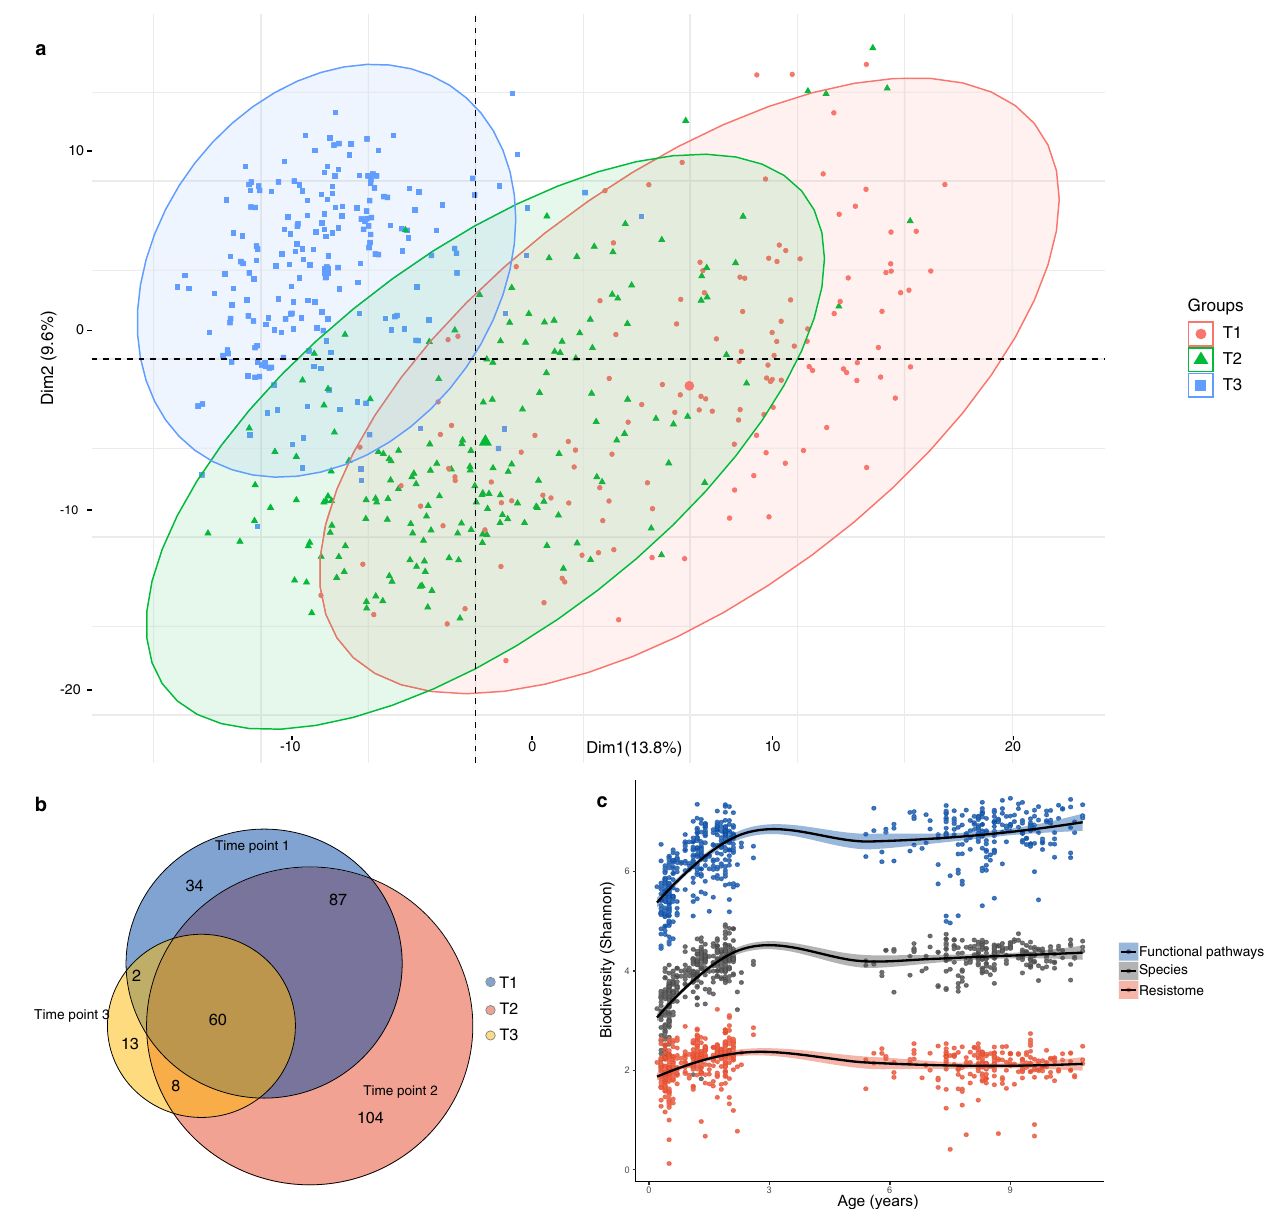
Fig. 2 | Temporal changes in ARGs and the overall oral microbiome by dental development. a Principal component analysis was performed on individuals using the TPM normalised ARGs that had been fi ltered to remove low abun- dance ARGs (below 0.01%), total sum scaled (TSS) and centre log ratio (CLR) transformed. Individuals are coloured by time point to observe temporal effects and 95% con fi dence intervals of groupings presented. b Distribution of unique and shared ARGs by time point. c α -diversity (Shannon Index) of the